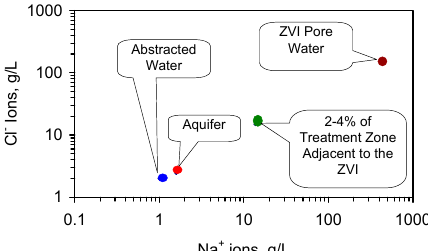
Figure C5. Salinity distributions in a synthetic “ Aquifer Treatment Zone ” following 69.65 h operation. Type B Catalyst. Saline water enters the treatment zone at an average rate of 15.8% h − 1 of the water volume in the treatment zone; Aquifer Treatment Zone Volume = 5.8 L; Water Volume Treated = 63.8 L; Temperature = 5–12 °C; P w = 23 g Fe/L [16]; Pellet casing: MDPE (0.02 m × 0.5 m); Water Recycle Rate: 50% to 67% h − 1 of the water volume contained in the Aquifer Treatment Zone ; Average time spent in the treatment zone = 5.3 h; Average Na + concentration in the feed water = 1.65 g·L − 1 ; Average Cl − concentration in the feed water = 2.56 g·L − 1 ; Average Na + concentration in the product water = 1.01 g·L − 1 ; Average Cl − concentration in the product water = 2.02 g·L − 1 ; Average salinity reduction = 28.1%; Removed ions retained in the ZVI = 40.98 g Na + ions (38.9%) + 34.46 g Cl − ions (21.1%). Average pH of feed and product water = 5.99; Eh of feed water = 545 mV. Eh of product water = 587 mV. ZVI Type: E143 [16], see References [16,17] for batch operation details associated with this ZVI Type. Scale-up factor required to achieve a throughput to 20 m 3 /d =